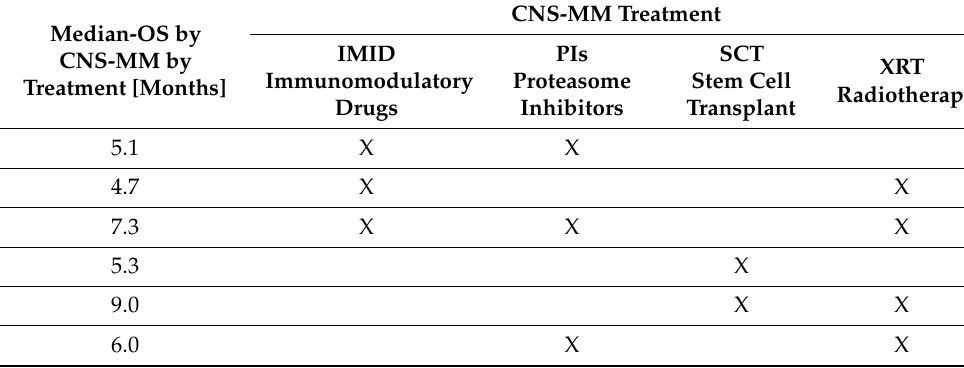
Table 3. Summary, where data were available. Data from Egan PA, Elder PT, Deighan WI, O’Connor SJM, and Alexander HD. Multiple Myeloma with Central Nervous System Relapse [1]. Median-OS